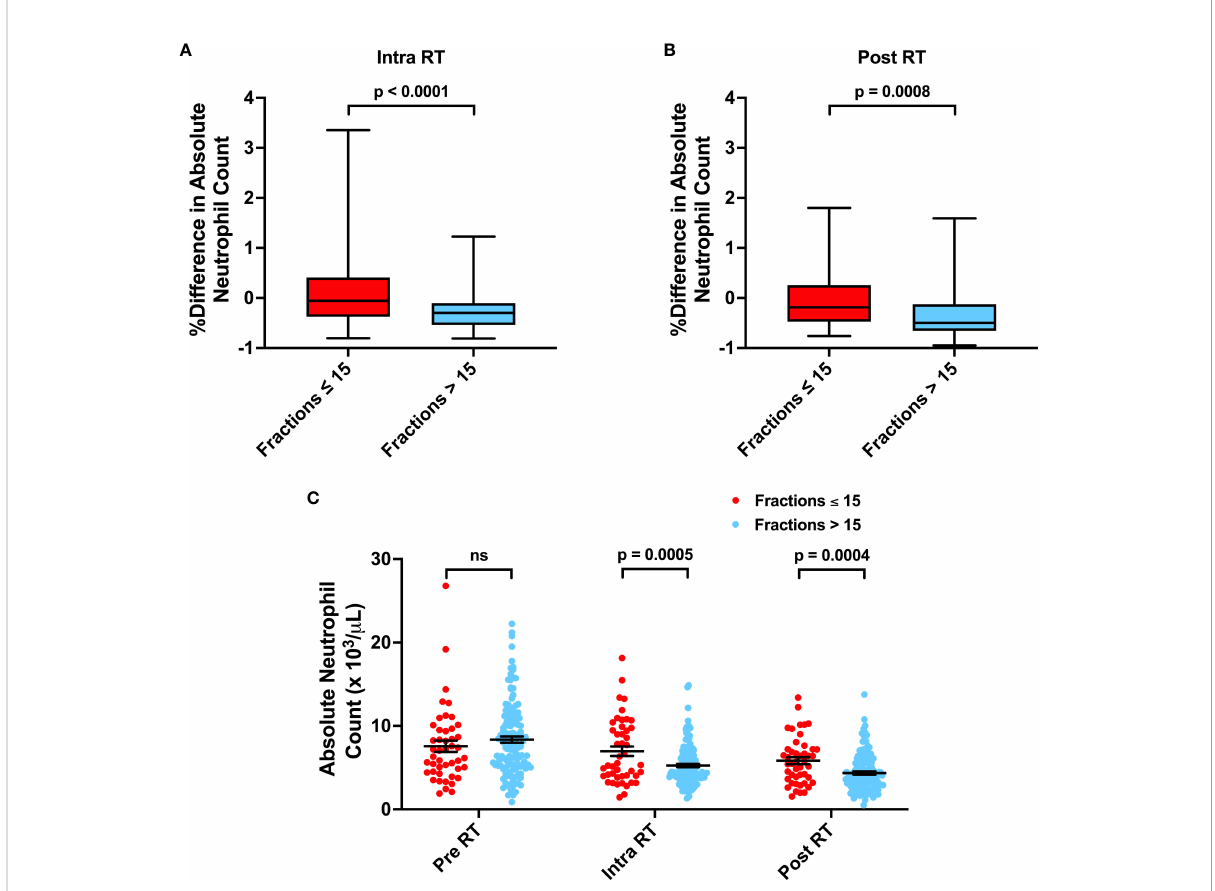
FIGURE 4 Associations between Number of Radiation Fractions and Neutrophil Counts. (A, B) Percent difference in neutrophil counts for patients receiving ≤ 15 or > 15 fractions from before radiation treatment (RT) to during RT or after RT. (C) Absolute neutrophil counts before, during, and after RT for patients receiving ≤ 15 or > 15 fractions. Statistical analysis was performed using two sample t-tests. ns, not signi fi